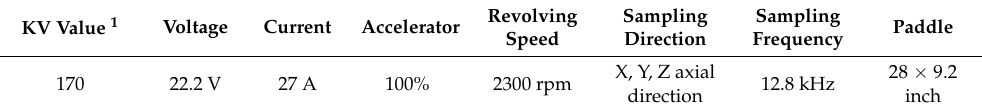
Figure 8. Fixture and devices used in the experiment: ( a ) fixture; ( b ) experiment devices.